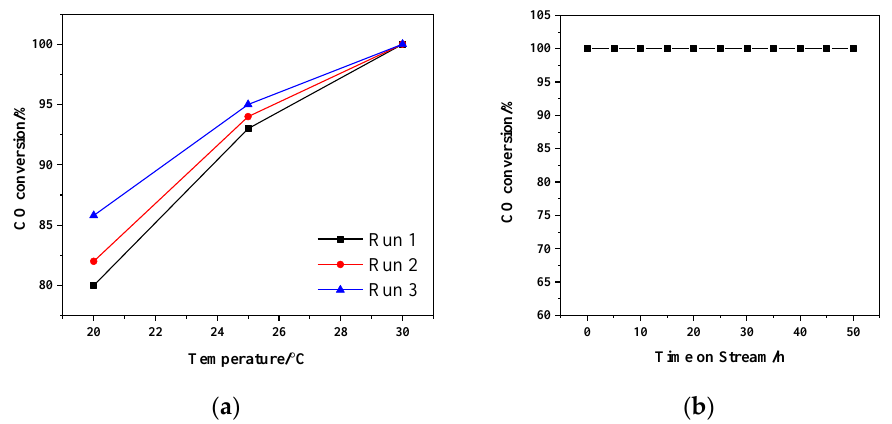
Figure 9. ( a ) Reproducibility of 1.86% Au/α-Fe 2 O 3 catalyst calcined at 300 °C for 2 h in CO oxidation reaction; ( b ) the lifetime test of 1.86% Au/α-Fe 2 O 3 catalyst calcined at 300 °C for 2 h at 30 °C (T 100 ).